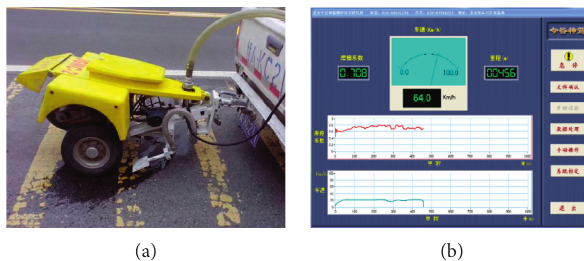
Figure 2: The pavement surface friction coefficient test equipment: (a) test trailer and (b) data acquisition system.